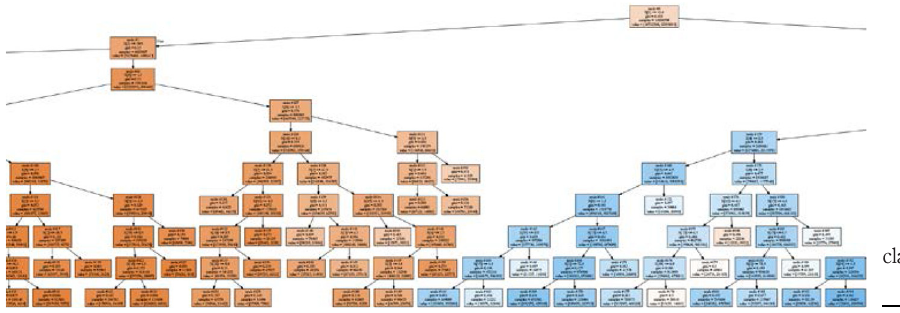
Figure 4. A visualization of classi fi cation